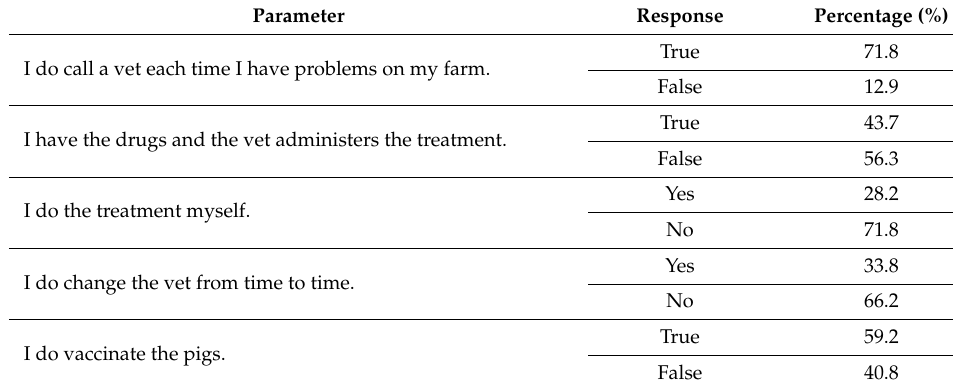
Table 12. Farmers practices that may increase the spread of the virus. Parameter